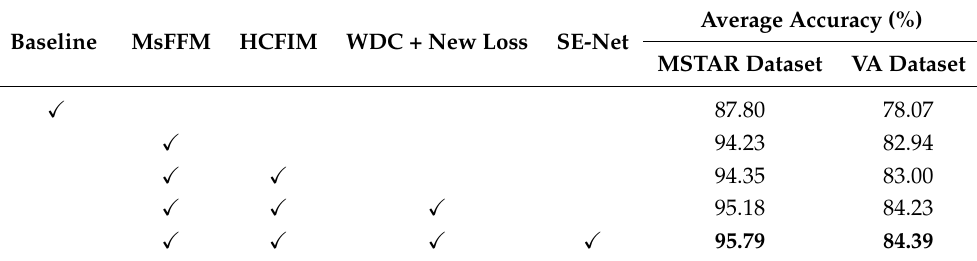
Table 8. The results of further ablation study on both datasets.